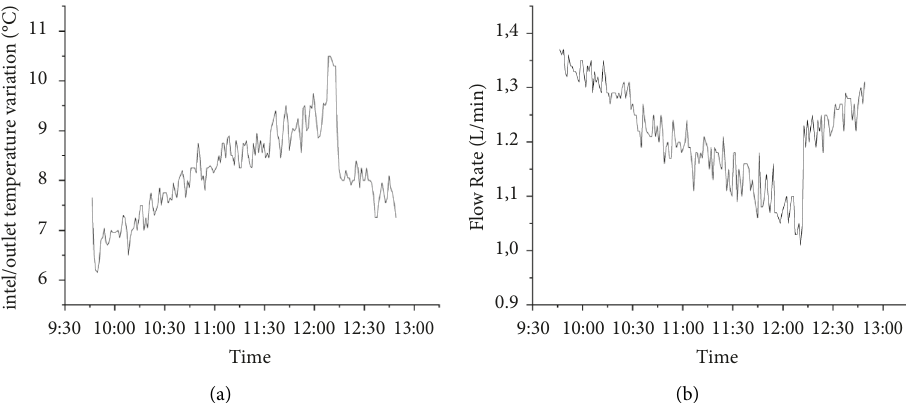
Figure 8: Graph with PTSC operating data: (a) temperature and (b) flow rate variation for measurements carried out on